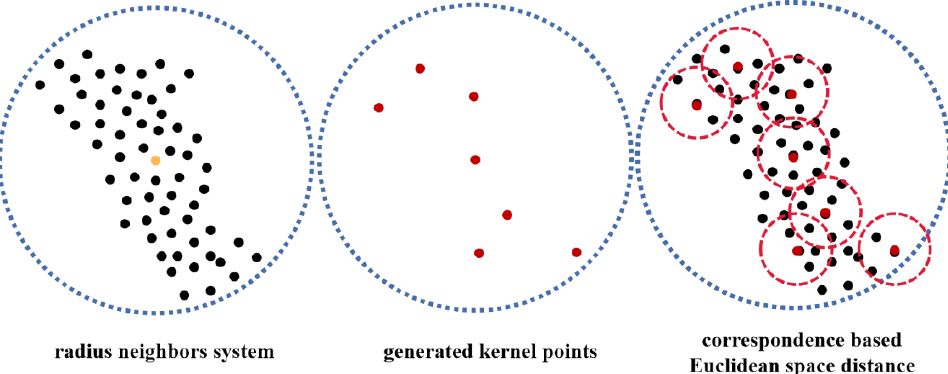
Figure 6. The correspondences based on Euclidean spatial locations in 3D point clouds. The left-hand circle shows the convolution range in a radius neighbor system, where the orange point is the convolution point and the points in the blue dotted circle are its neighbors. The middle circle shows the convolution kernel points generated by a certain function; these points will have 3D spatial coordinates. The right-hand circle describes the correspondence relationships based on the Euclidean spatial location.